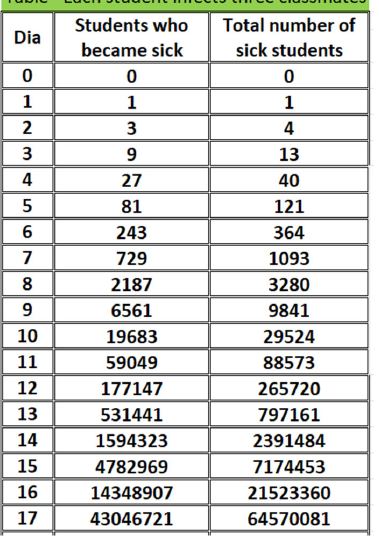
Figure 6. Examples of Excel files.